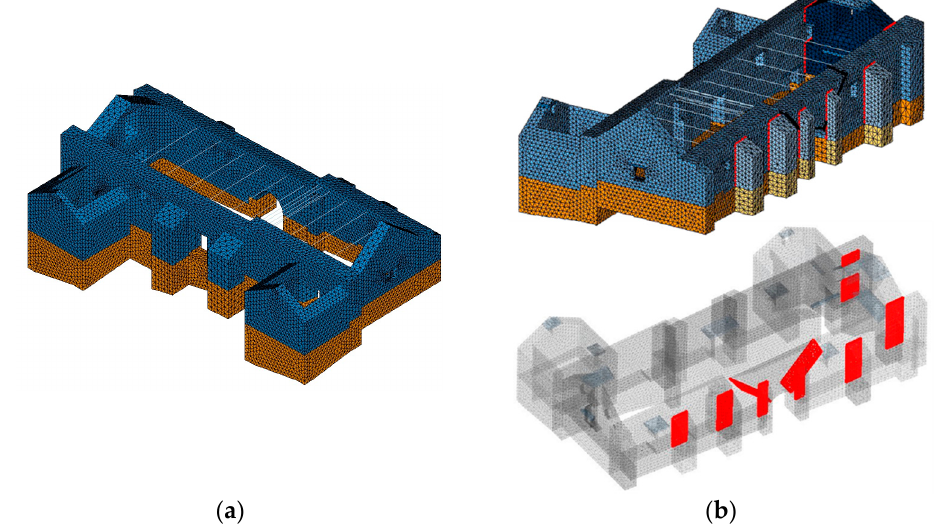
Figure 13. ( a ) Configuration of MODEL_1; ( b ) Configuration of MODEL_2. Note the definition of interfaces in red .